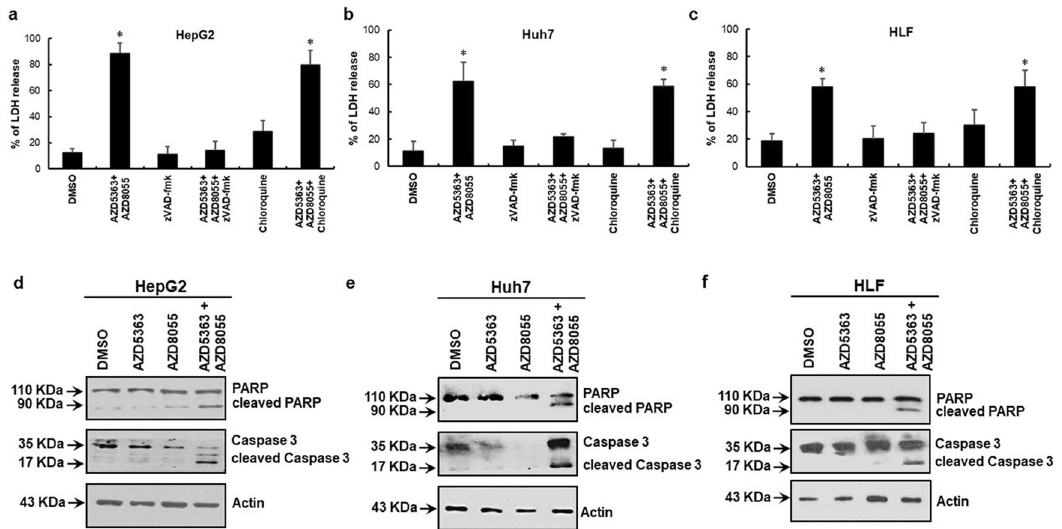
Fig. 2 Induction of apoptosis in HCC cells upon combined inhibitor treatment. Cell death was analyzed from LDH release assay at 72 h after combined treatment with 5 µM AZD5363 and 100 nM AZD8055 in the presence of 50 µM zVAD-fmk or 25 µM chloroquine in HepG2 ( a ), Huh7 ( b ), and HLF ( c ). The results are presented as the mean ± SD from three independent experiments. * P < 0.05 was regarded as signi fi cant. Western blot analysis was performed from HCC cell lysates following treatment with individual or a combination of 5 µM AZD5363 and 100 nM AZD8055 for 48 h. The expression status of PARP and Caspase 3 with their cleaved fragments in HepG2 ( d ), Huh7 ( e ), and HLF ( f ) cells are shown. The expression level of actin in each lane was considered for comparison of protein load and illustrated by representative blots shown at the bottom.